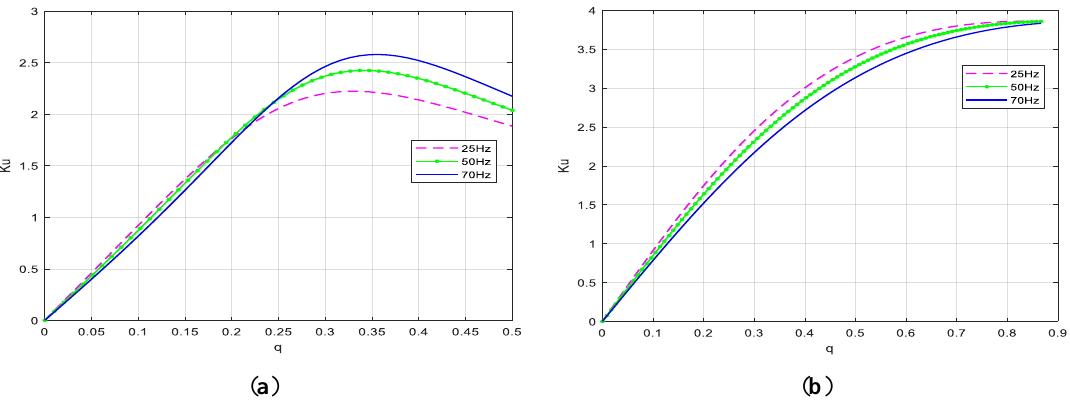
Figure 8. Static characteristics of voltage gain: ( a ) Venturini modulation, ( b ) SVM .